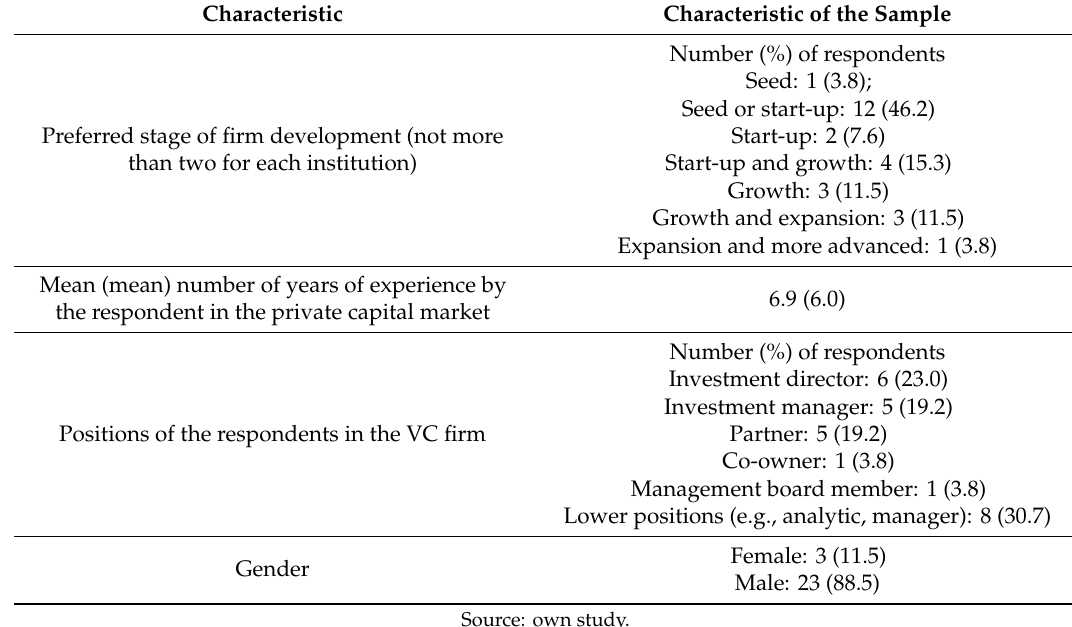
Table 6. Characteristics of the VC firms and respondents in the study.